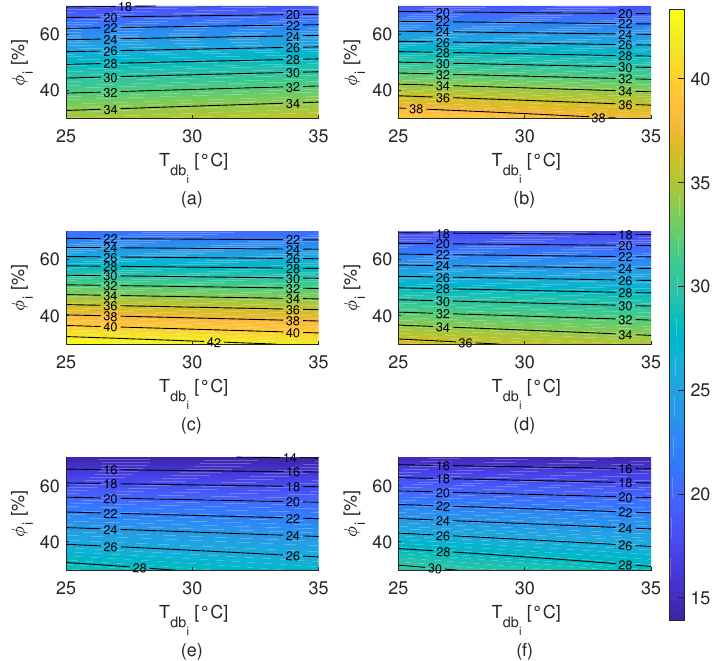
Figure A10. Difference between the outlet and inlet pad air relative humidity ( ∆ φ ) as a function of dry-bulb temperature of inlet air ( T db ) and relative humidity ( φ i ) for the pad materials studied. ( a ) Cel- i lulose. ( b ) Small coconut shell (7.9–12.7 mm). ( c ) Big coconut shell (12.7–19.0 mm). ( d ) Burnt-clay bricks (12.7–19.0 mm). ( e ) Small pumice stones (34.9–45.0 mm). ( f ) Big pumice stones (45.0–55.5